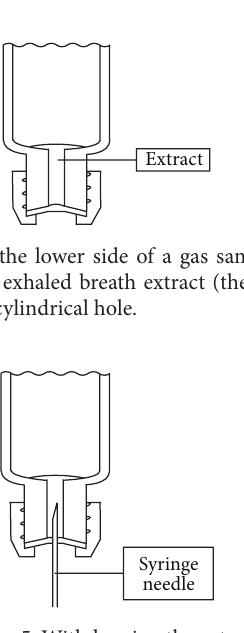
Figure 5: Withdrawing the